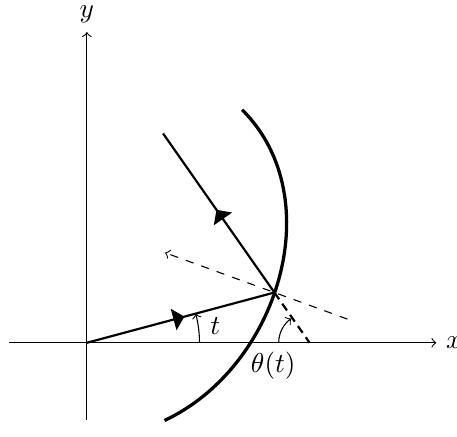
Figure 1. Illustration of the law of